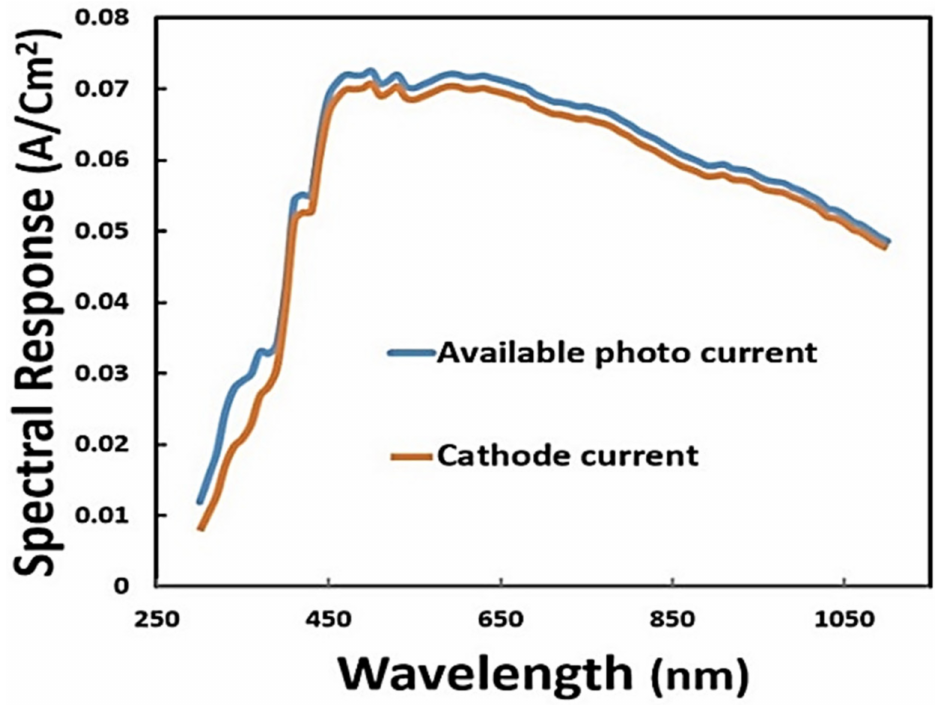
Figure 3. Available photo current and cathode current versus optical wavelength for case